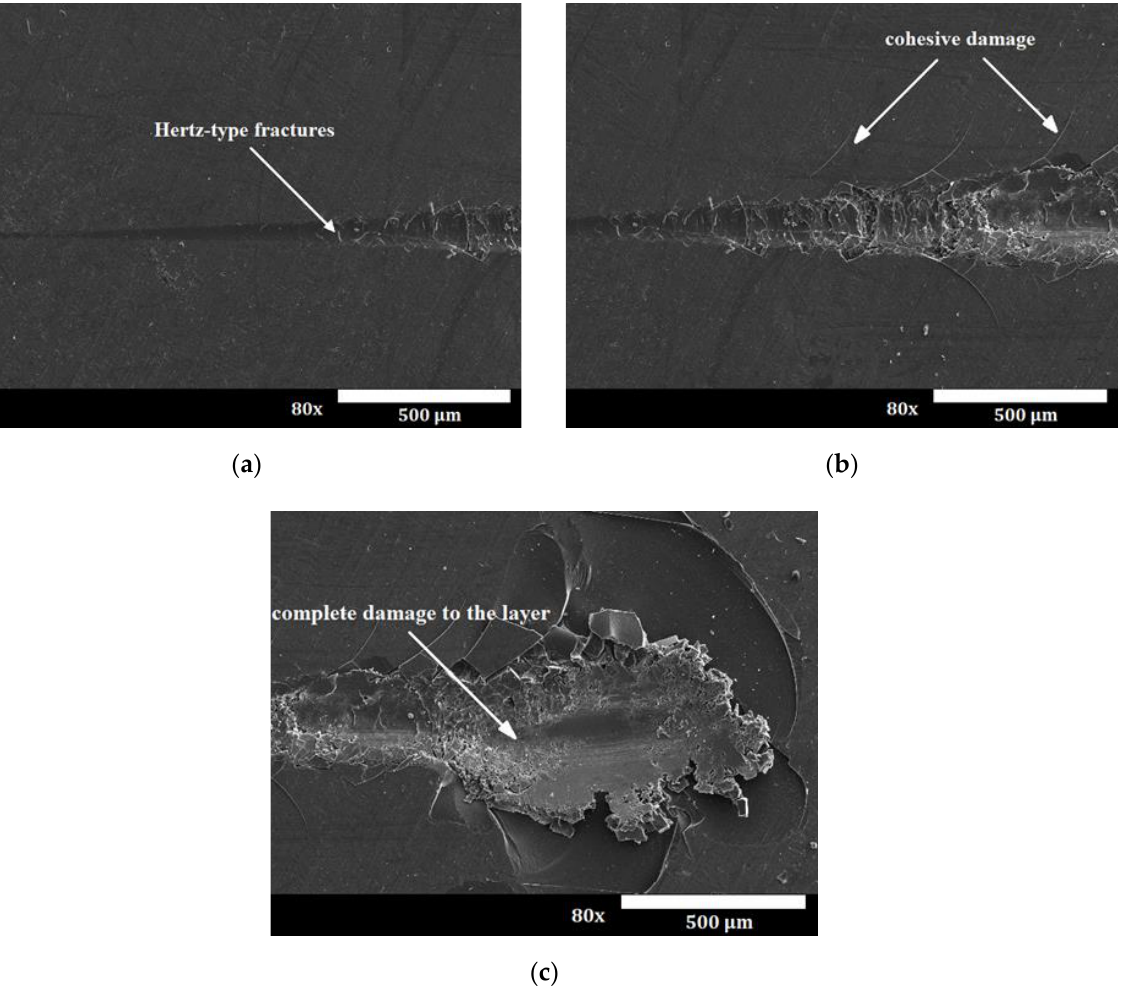
Figure 3. Damage to tested layers: ( a ) Hertz cracks, ( b ) cohesive damage, ( c ) adhesive damage and complete damage to layers.